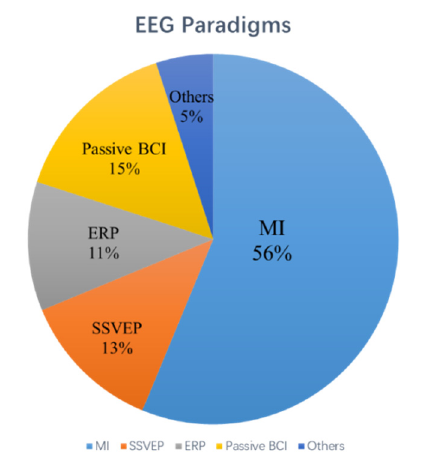
Figure 3. The percentage of different EEG pattern strategies across collected studies.